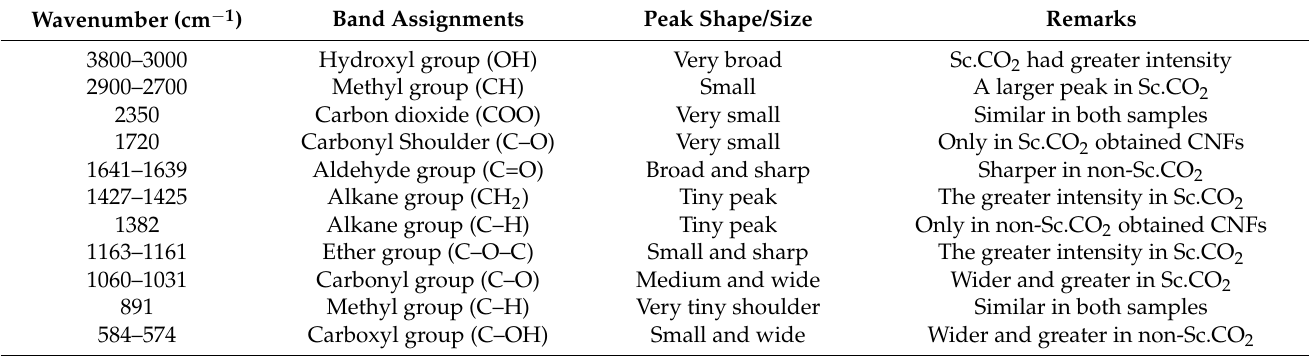
Table 3. Summary of the peak location, shape, and size of the infrared bands of the main CNFs chemical functional groups obtained from FTIR analysis.